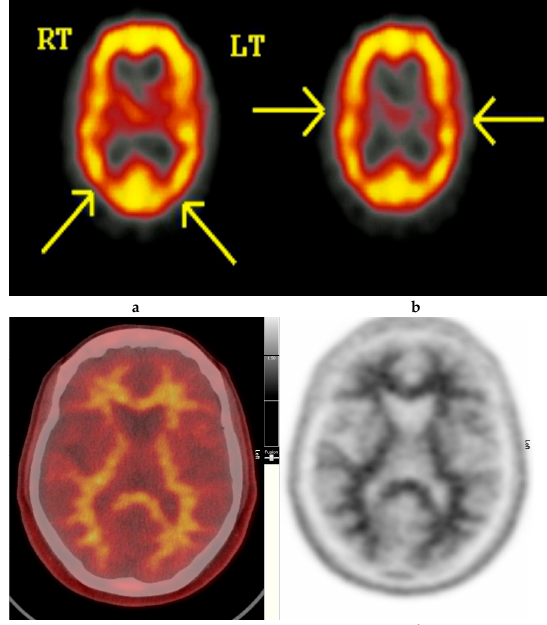
Figure 2. Normal study. Fifty-seven year old female patient memory problems/loss and confusion with a query of Alzheimer’s disease. ( a ) and ( b ) Technetium-99m HMPAO-SPECT brain Scan [ 99m Tc]HMPAO-SPECT brain scan. Brain scan showed mildly reduced perfusion to both temporal and both parietal lobes (yellow arrows) with relatively better perfusion anteriorly. Reduction of cerebral blood flow in these regions is commonly seen in patients with early Alzheimer’s dementia rather than vascular dementia. However, in view of the subtle nature of the appearances on the [ 99m Tc]HMPAO-SPECT brain scan, the [ 18 F]FBP brain scan was performed to identify beta amyloid plaque disease and to give a higher confidence for AD diagnosis or suggest vascular aetiology. ( c ) Color coded [ 18 F]FBP scan. ( d ) Grey scale [ 18 F]FBP scan shows good contrast between grey and white matter in sections of the brain and no obvious evidence of beta amyloid plaque disease. This means that the likelihood of developing AD is low and as such the overall findings are more suggestive of vascular aetiology rather than early AD. (Figures are courtesy RLBUHT Hospital